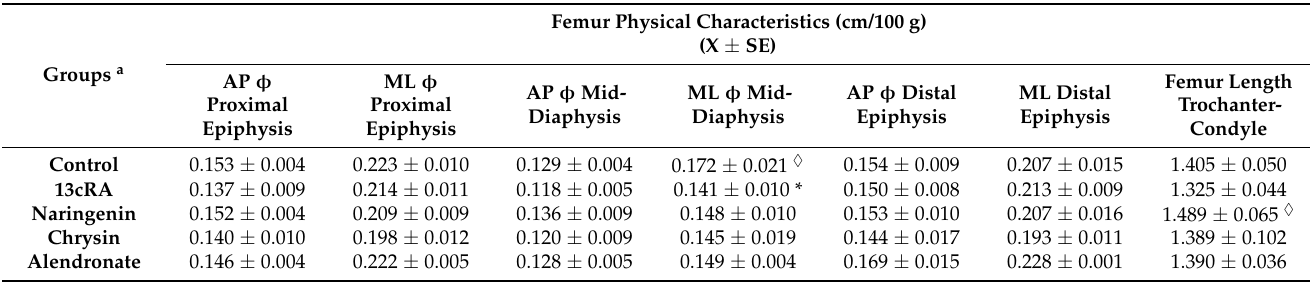
Table 1. Effects of naringenin, chrysin, or alendronate on femur physical characteristics in rats with retinoic-acid-induced osteoporosis.